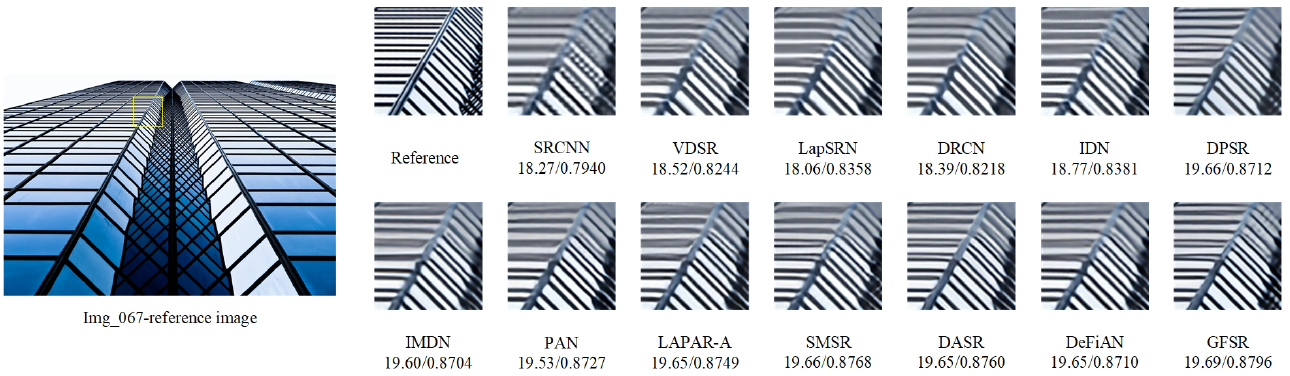
Figure 11. Visual comparison of super-resolution results of ‘Img_067’ (Urban100) obtained by different SR algorithms with scaling factor